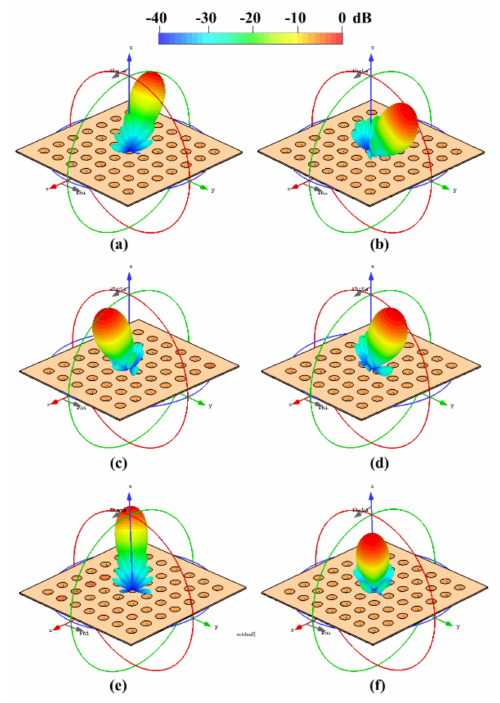
Figure 13. 3D radiation pattern obtained by CST electromagnetic solver: configuration 1 at ( φ 0 = 0 ◦ , θ 0 = 25 ◦ ) ( a ), and ( φ 0 = 90 ◦ , θ 0 = 40 ◦ ) ( b ); configuration 2 at ( φ 0 = 0 ◦ , θ 0 = 25 ◦ ) ( c ), and φ 0 = 90 ◦ , θ 0 = 25 ◦ ( d ); configuration 3 at ( φ 0 = 225 ◦ , θ 0 = 25 ◦ ) ( e ), and ( φ 0 = 45 ◦ , θ 0 = 25 ◦ ) ( f